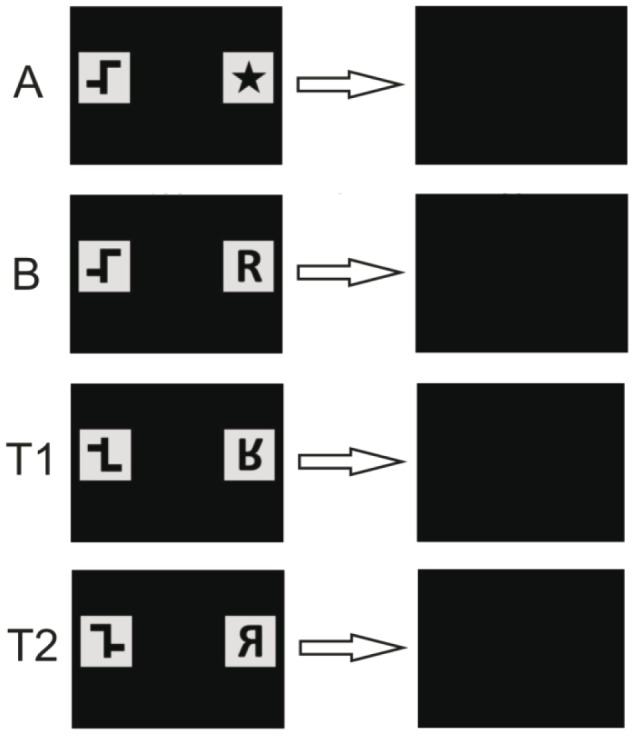
Chronology of the sequences of PowerPoint slides used in experiment 2b.The positive stimulus is shown on the left. (A) Asymmetrical shape vs. star. (B) Asymmetrical shape vs. letter ‘R’. (T1) Vertical mirror-image of stimulus pair C used for transfer tests. (T2) Horizontal mirror-image of stimulus pair C used for transfer tests. The last slide denotes the ITI.